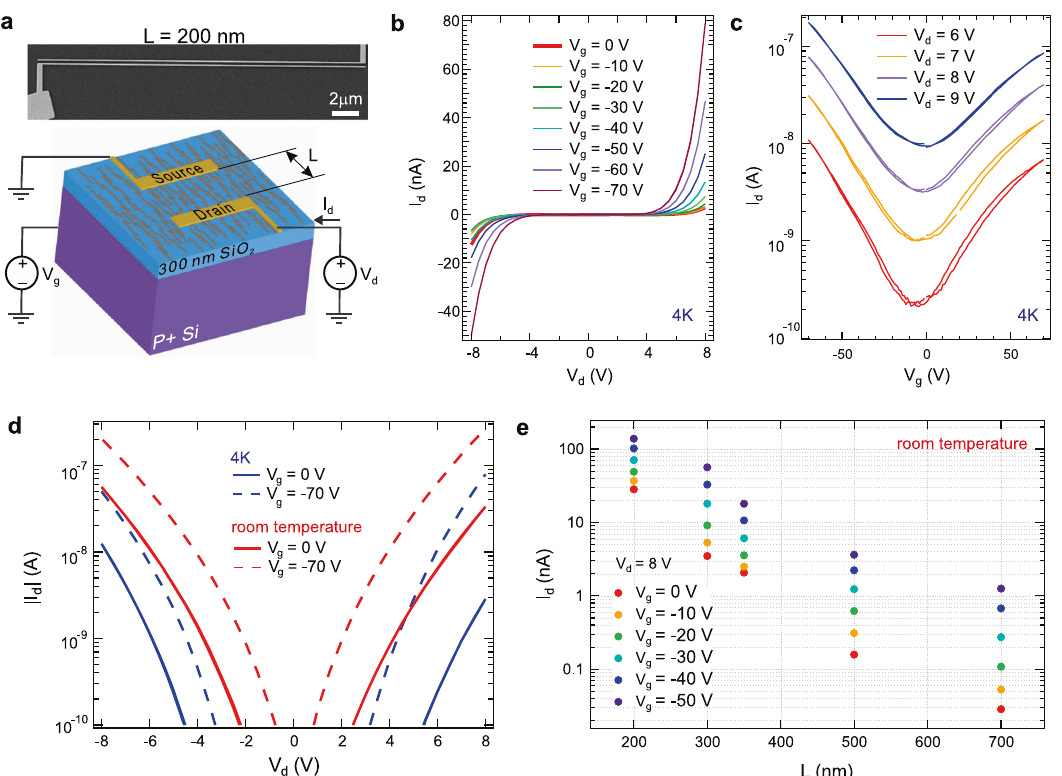
Fig. 3 Charge transport characterization of the transferred GNR heterojunctions. a Top: scanning electron microscopy image of the device with the channel length L = 200 nm and the channel width W = 25 μ m. Bottom: sketch of aligned GNR heterojunctions on SiO 2 /Si in a FET geometry with source, drain, and gate contacts. b – d Transport characteristics of the device with L = 200 nm. b I d – V d curves at different V g , and c I d versus V g at different V d at 4 K. d I d – V d curves in log scale at 4 K (blue) and room temperature (red) at V g = 0 and − 70 V. e Channel length dependence of the I d at V d = 8 V and different V g at room